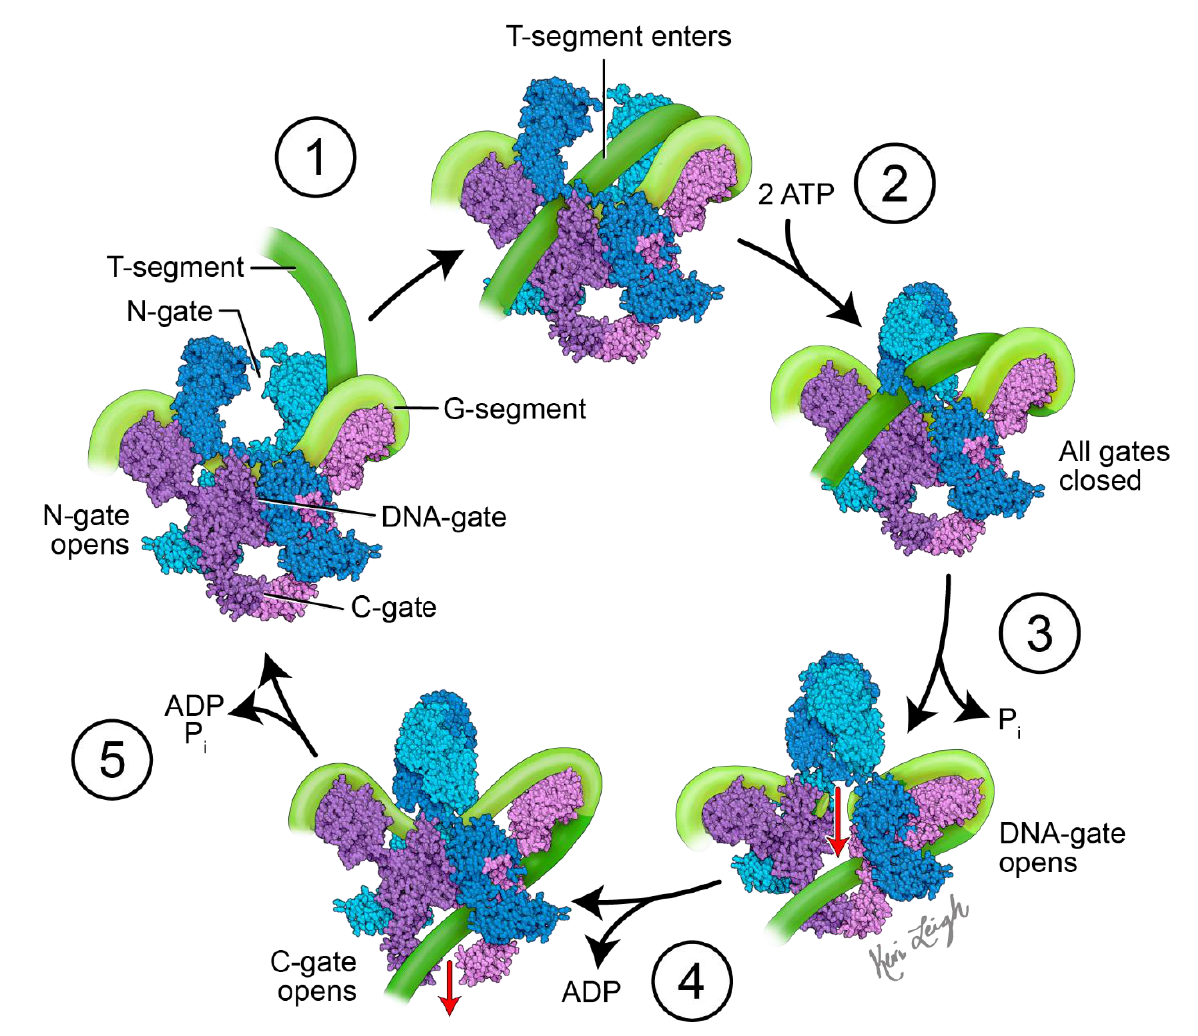
Figure 1. Proposed mechanism of action of DNA gyrase. Initially, DNA gyrase is bound to a G-segment of DNA at the DNA gate, a region located at the interface between subunits A (purple and pink) and B (blue and teal). The G-segment of DNA (light green) is wrapped around the C-terminal domains (CTDs) of the A subunits. The mechanistic steps are as follows: (1) the T-segment of DNA (dark green) enters the gyrase via the N-gate formed by the two B subunits. (2) When two ATP molecules bind the B subunits, the N-gate closes, and the T-segment DNA is trapped in the upper cavity of the gyrase. (3) The G-segment is cleaved, opening the DNA gate and allowing the T-segment to pass through into the lower cavity. This step requires the hydrolysis of one ATP with the release of P i. (4) The C-gate opens, and the T-segment passes through with the release of ADP. The second ATP is hydrolyzed. (5) The release of ADP and P i , along with the closing of the C-gate and opening of the N-gate, readies DNA gyrase for another cycle of supercoiling. The diagram is based on Soczek et al. [24]. The structure of DNA gyrase was derived from PDB ID 6RKW [25]. Figure created by medical illustrator Keri Leigh Jones, MSMI, CMI.